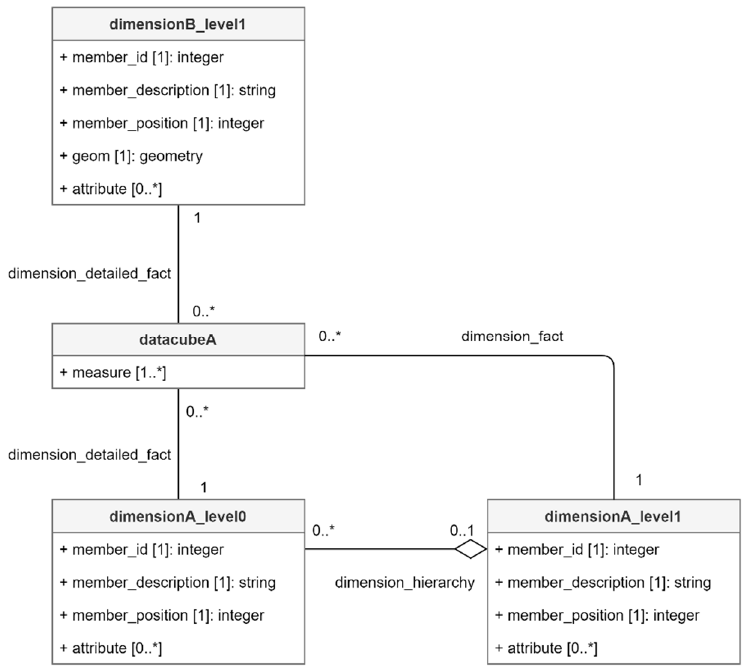
Figure 12. An instantiated data cube model. Asterisk means “n” according to UML convention.